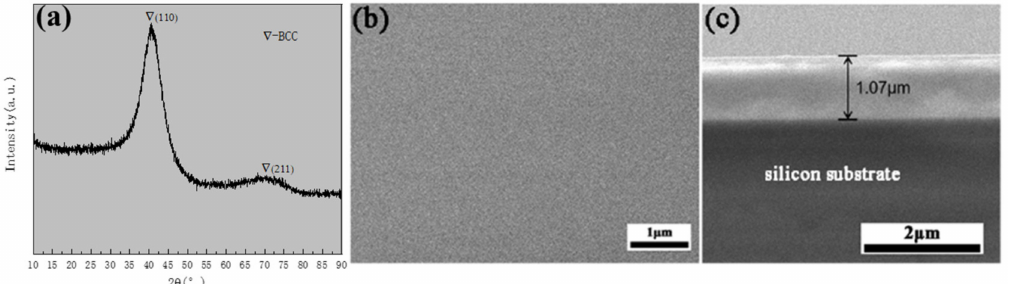
Figure 1. As-deposited Cr 20 Mn 17 Fe 18 Ta 23 W 22 RHEA: ( a ) The GIXRD pattern; ( b ) SEM surface image; ( c ) Cross-section SEM image.